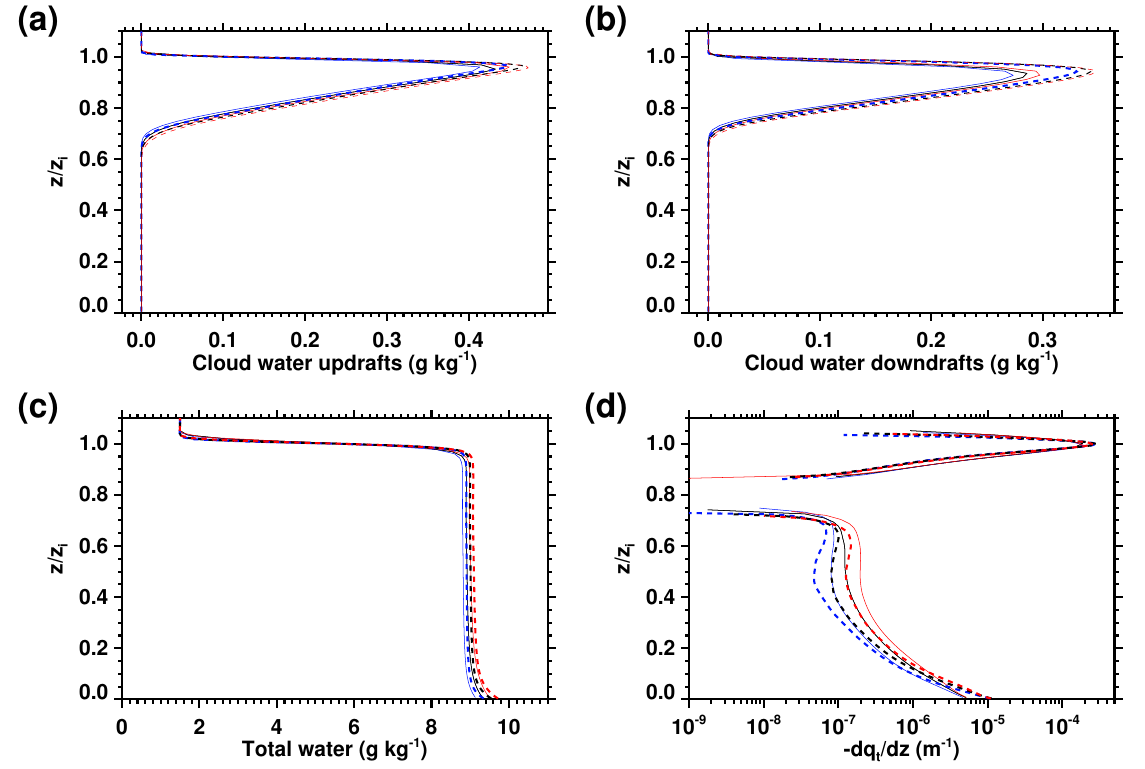
Figure C5. Effect of resolution. Profiles averaged over the period N (10:20–11:20UT) from simulations M − (blue), M 0 (black), M + (red), solid curves, and from simulations M −